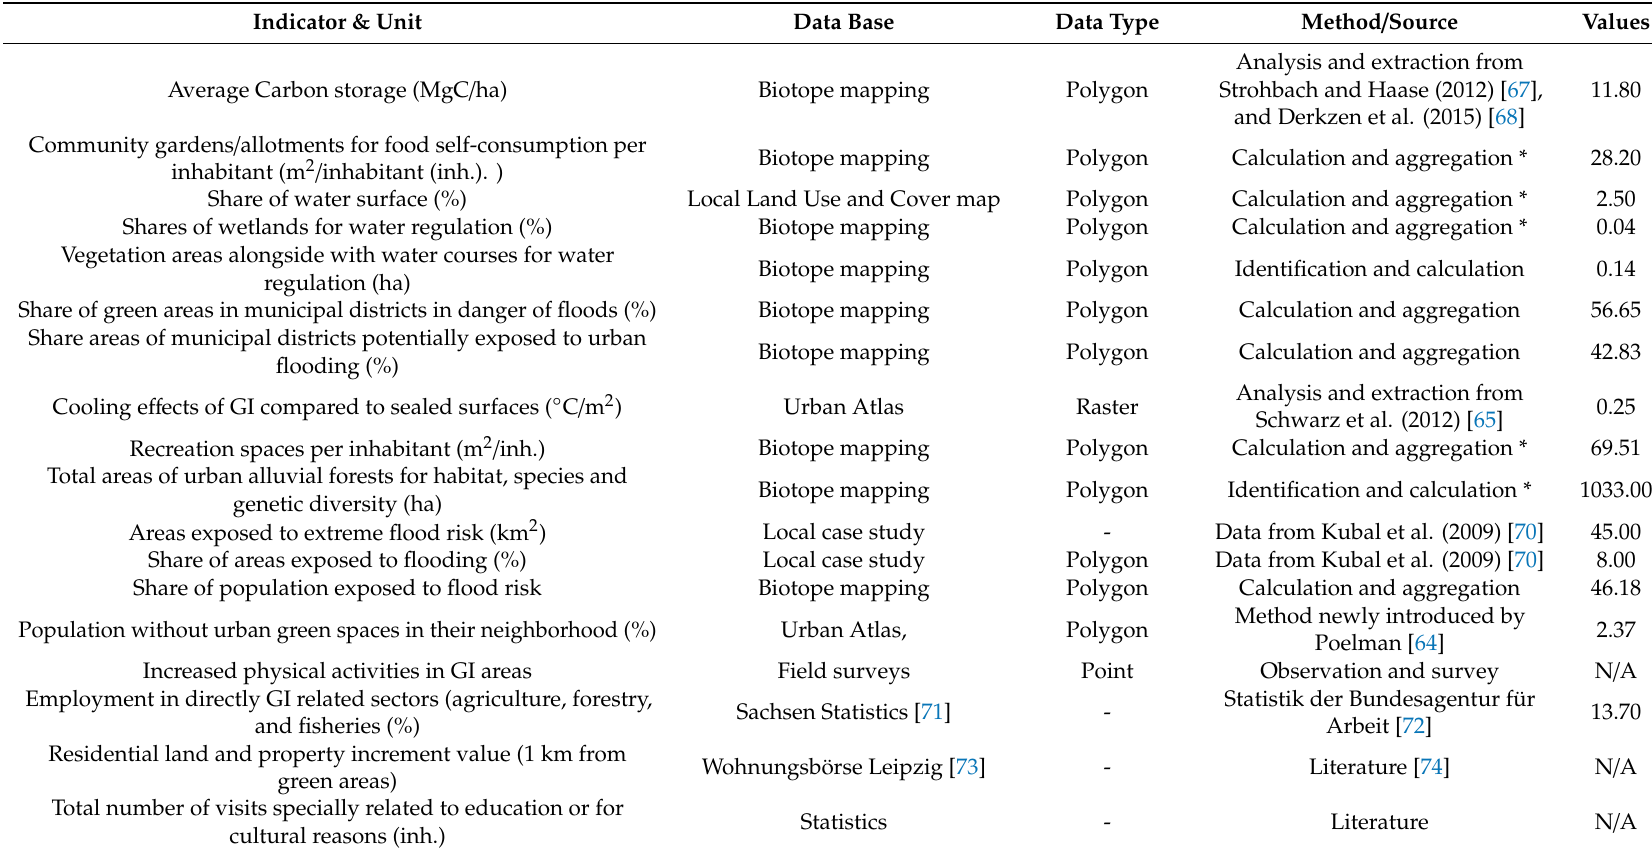
Table 2. A lean indicator framework to exemplify AMGI, adapted and selected from integrated